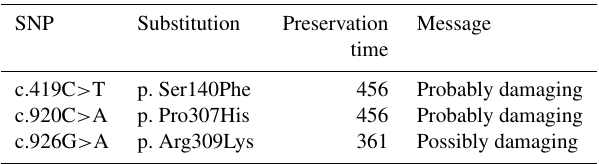
Table 4. Functional effect of non-synonymous substitution on buf- falo